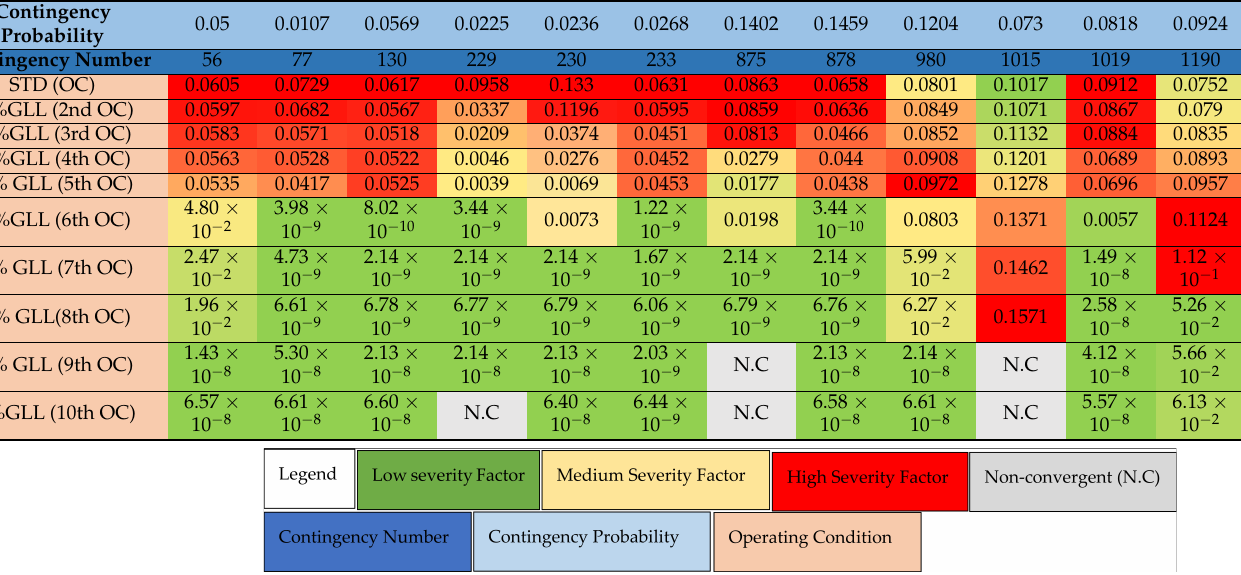
Table 5. Overvoltage severity factor behavior under varying operating